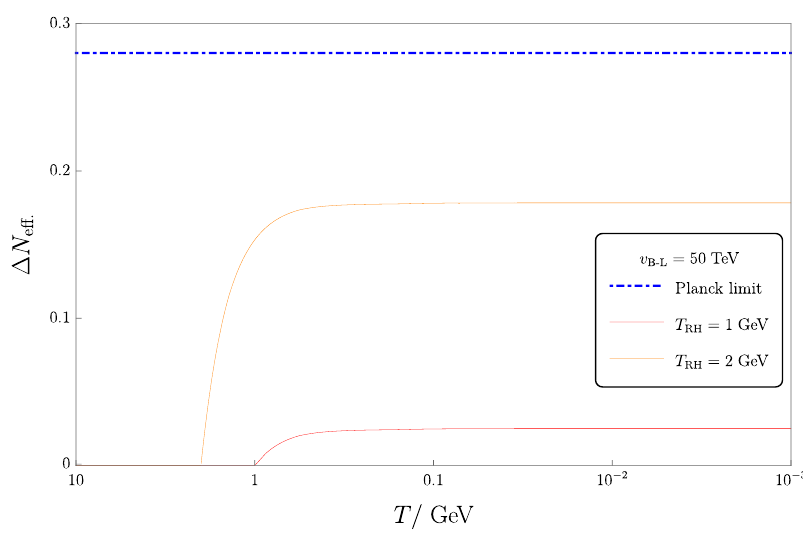
Figure 5 . ∆ N eff. as a function of temperature for fixed v B-L and two different T RH .